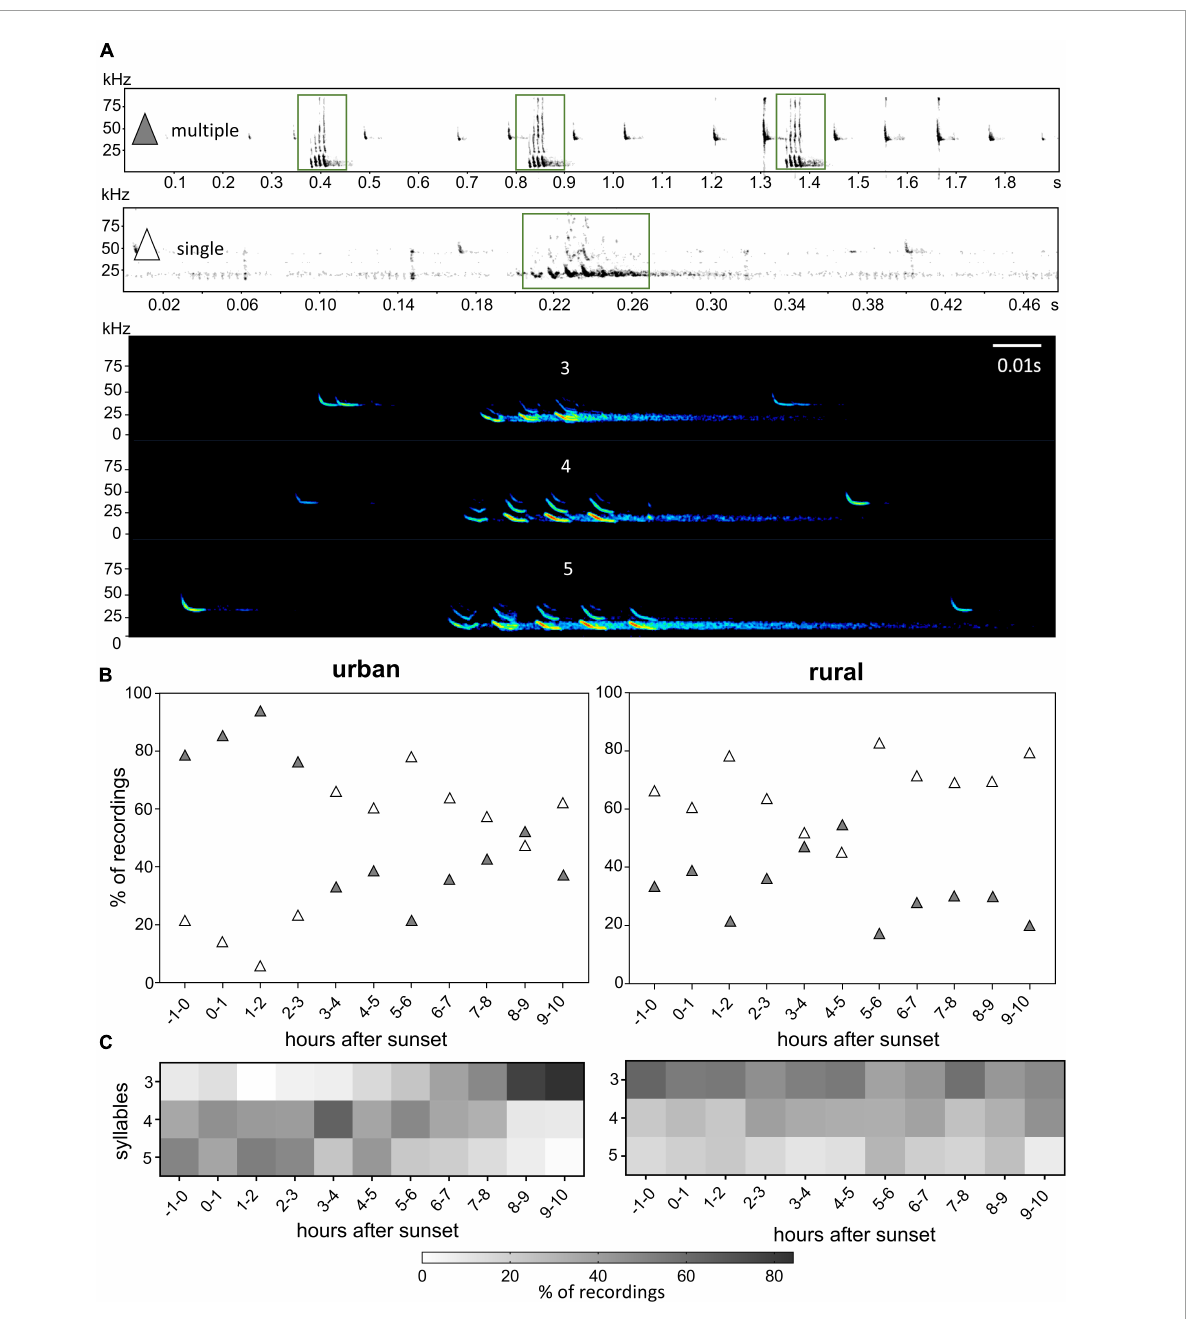
FIGURE3 Structural patterns of P. pipistrellus ’ Type D social calls on urban and rural study sites. Examples of different composition (single vs. multiple calls within a sequence) and call types (3, 4, and 5 syllables); green boxes show social calls interspersed between echolocation calls (A) . Nightly proportional distribution of social call sequences with single calls (white diamonds) and multiple calls (dark diamonds) (B) , and nightly proportional distribution of sequences with different syllables (C)